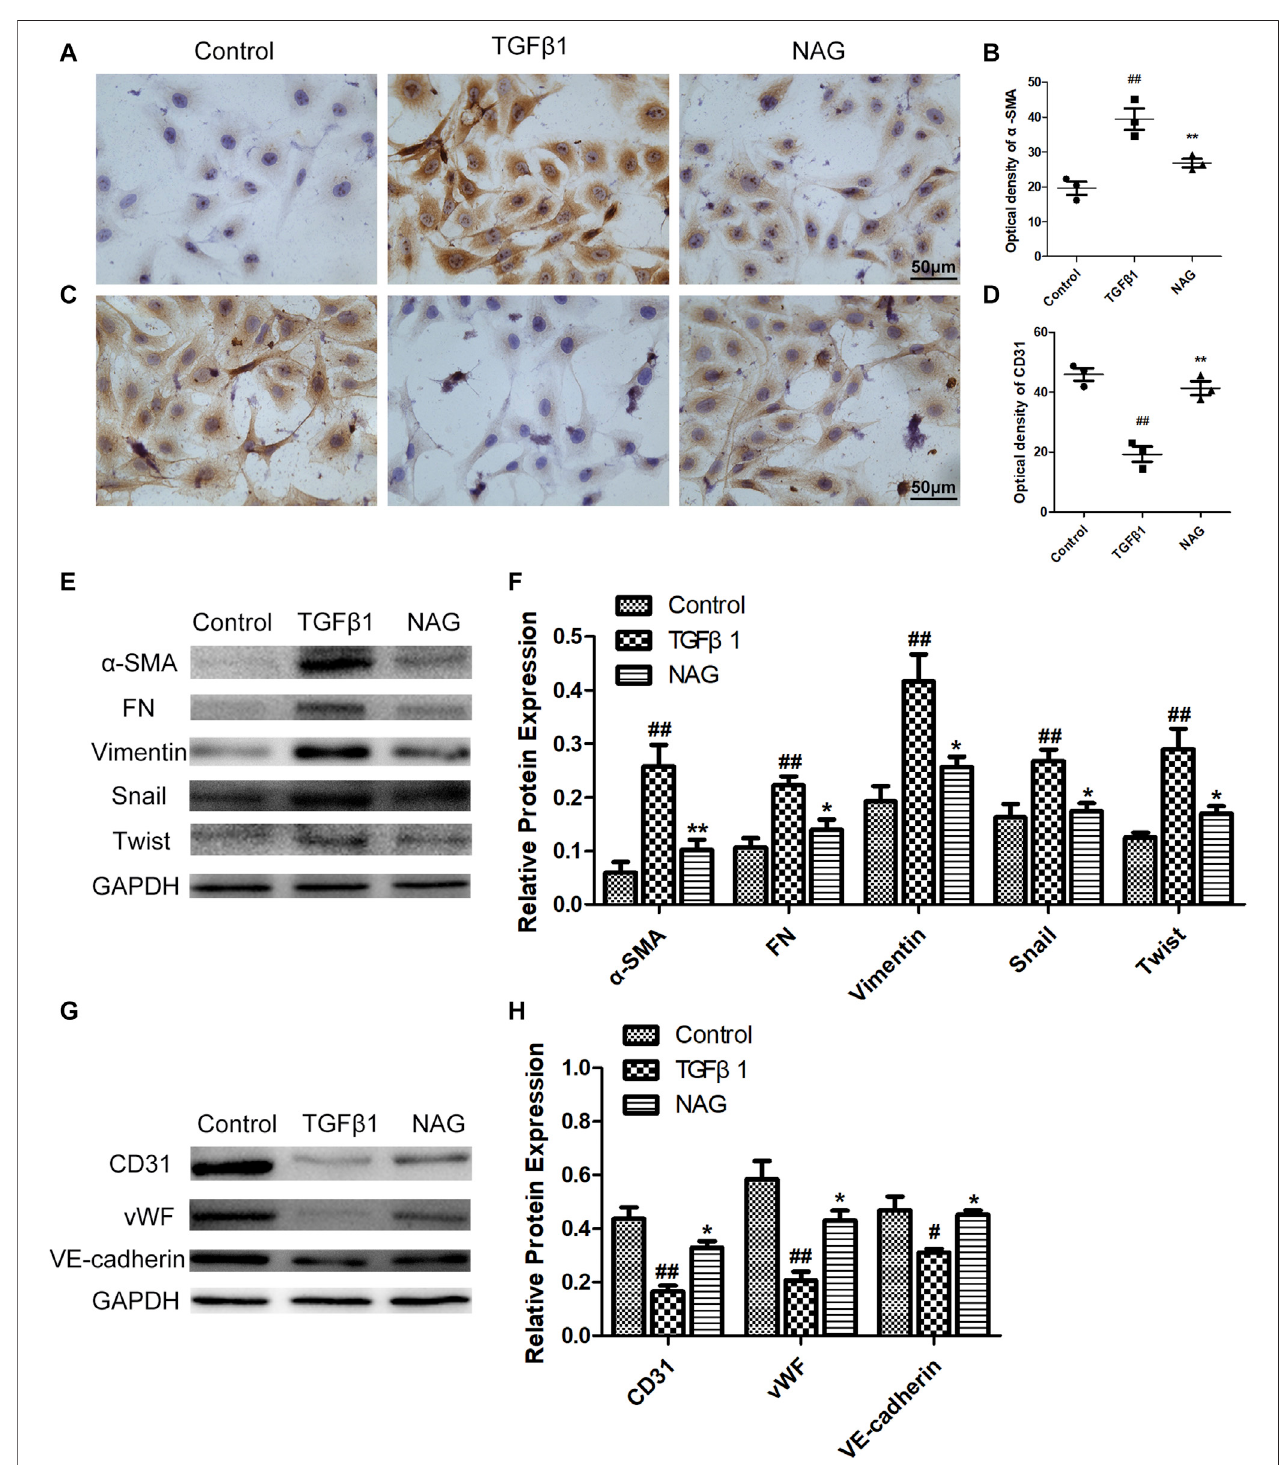
FIGURE 7 | Effects of naringin on expressions of α -SMA, FN, Vimentin, Twist, Snail, CD31, vWF, and VE-cadherin in TGF β 1-induced HUVECs. Serum-starved HUVECs were stimulated with TGF- β 1 (10 ng/ml) and with or without naringin (100 μ mol/L) for 48 h. The expressions of α -SMA (A) and CD31 (C) in HUVECs were analyzed by immunohistochemistry staining. Quanti fi cation of α -SMA optical density (B) and CD31 optical density (D) were calculated. The expressions of α -SMA, FN, Vimentin, Twist, Snail (E,F) and CD31, vWF, VE-cadherin (G,H) were analyzed with western blot. Magni fi cation × 400, scale bars (cid:1) 50 μ m ## p < 0.01 vs. control; ** p < 0.01 vs. TGF β 1. n (cid:1) 3.